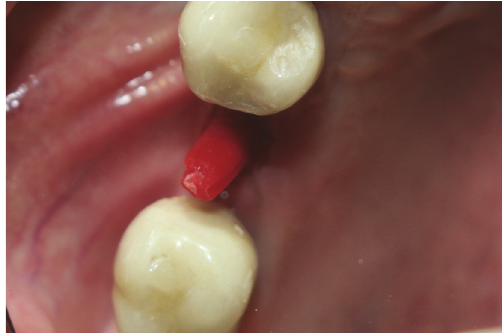
Figure 3: DuraLay